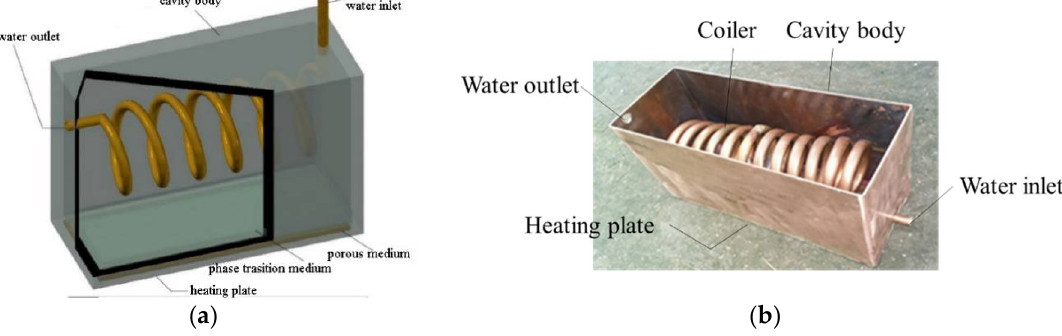
Figure 2. ( a ) Designed structure of the vacuum cavity; and, ( b ) Experimental structure of the vacuum cavity.